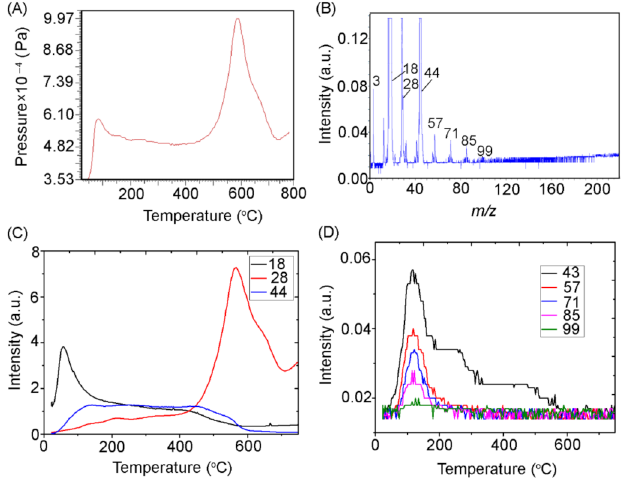
Figure 5. Thermal decomposition of P/CeO 2 (0.6 mmol/g); vapor pressure measured as a function of temperature for the FA/Al 2 O 3 sample ( A ); mass spectra at 120 ◦ C ( B ); TPD curves for ions with m / z 18, 28, and 44 ( C ); for ions with m / z 43, 57, 71, 85, and 99 ( D ).